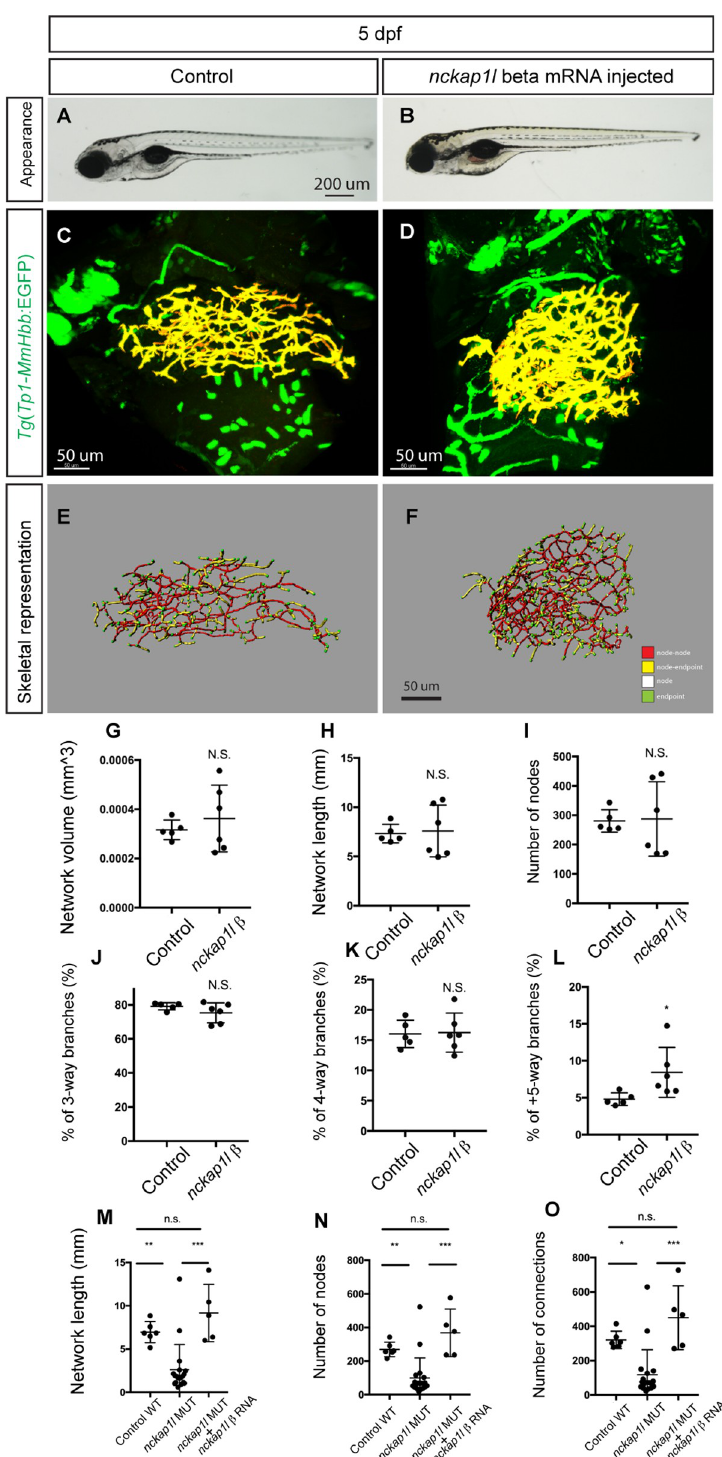
Fig 4. nckap1l ß overexpression induced biliary system-specific phenotypes. (A and B) Representative physical appearance of wild-type (WT) control (A) and nckap1l ß mRNA-injected (B) larvae at 5 dpf. Lateral views. At 5 dpf, there is no significant difference in physical appearance in larvae overexpressing nckap1l ß. (C and D) Projected confocal images of Tg(Tp1-MmHbb :EGFP ) um14 expression in WT (C) and nckap1l ß RNA-injected (D) larvae at 5 dpf. GFP expression in the intrahepatic biliary network is shown in pseudocolored yellow. (E and F) Skeletal